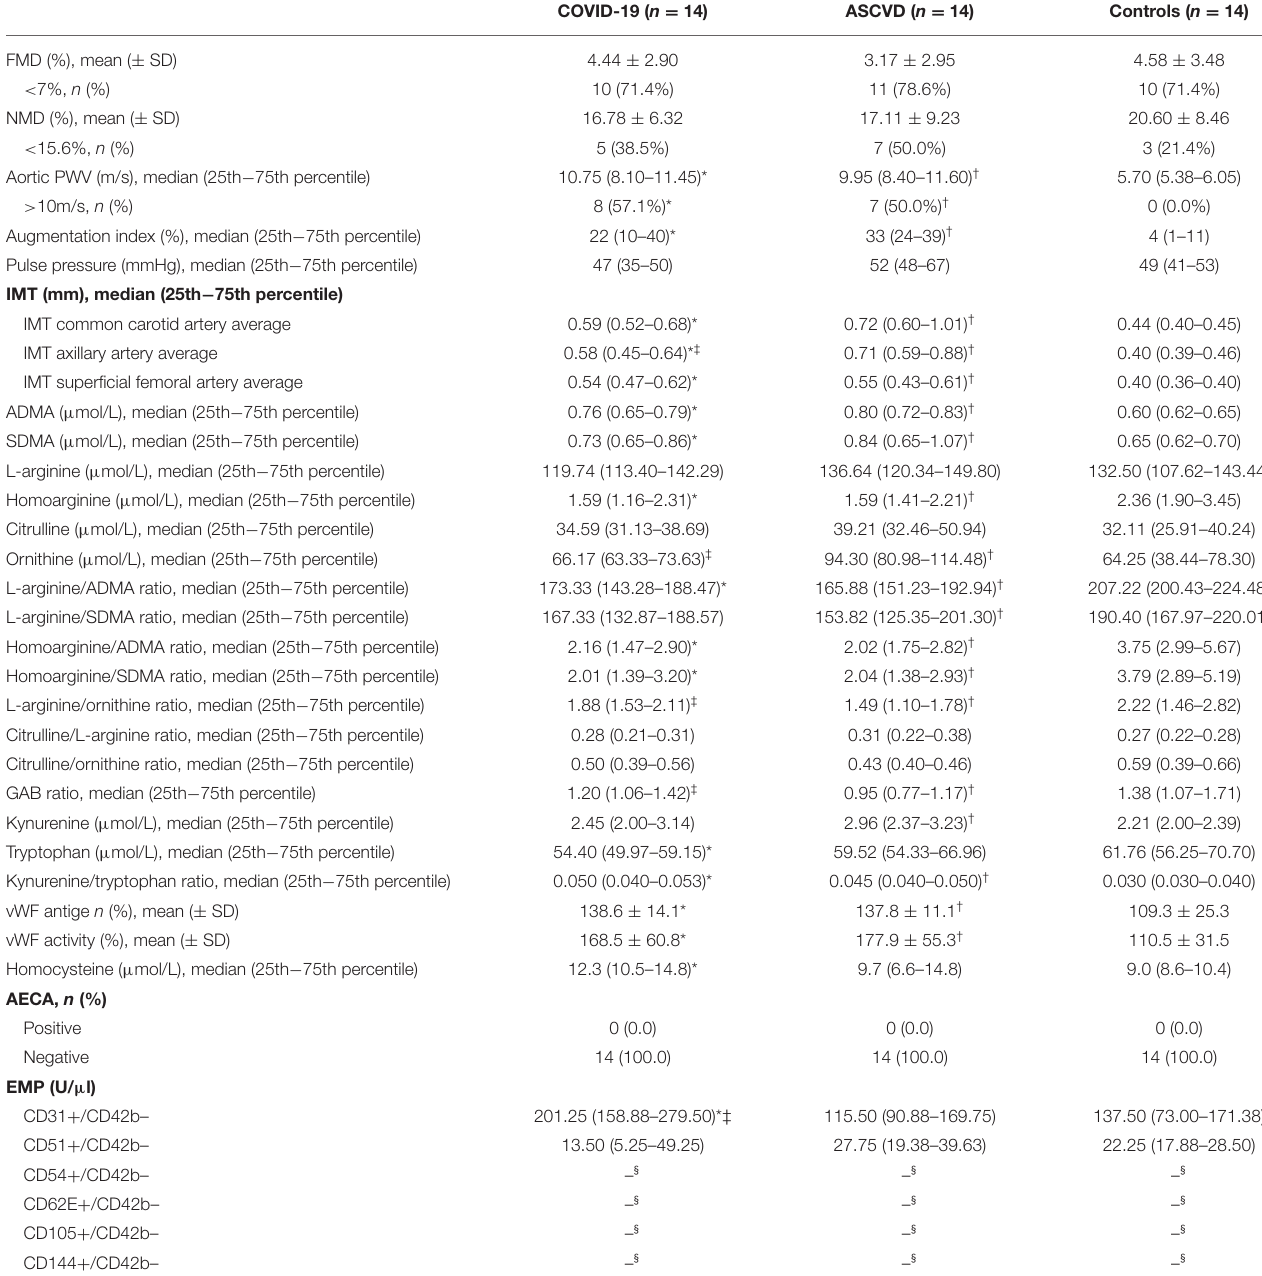
TABLE 3 | Parameters of endothelial